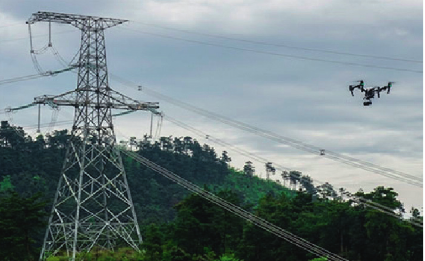
Figure 1: UAV-based autonomous transmission line